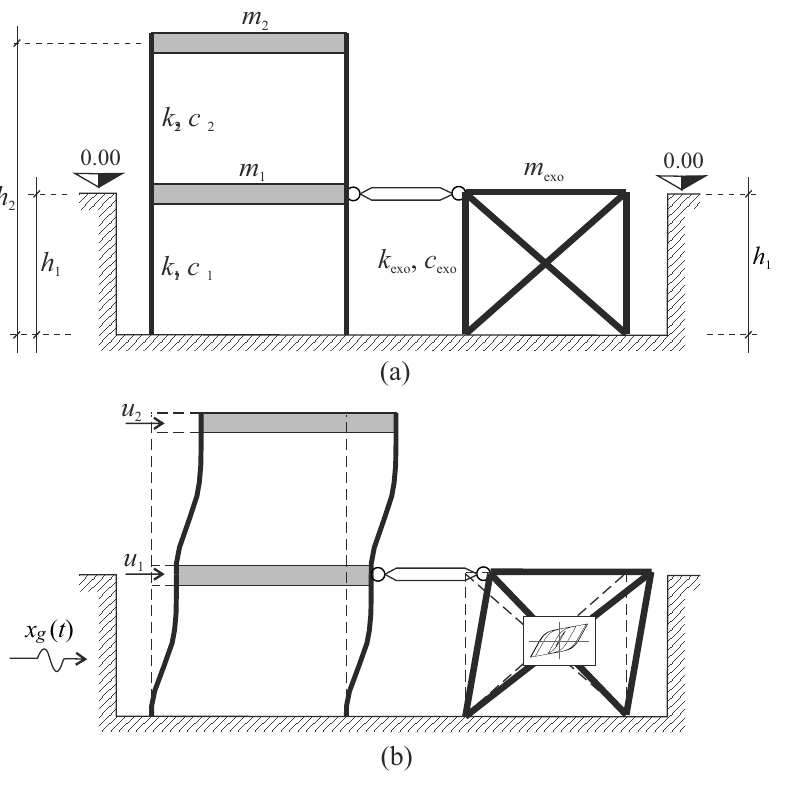
Figure 2. Mechanical system: ( a ) geometric and mechanical characteristics of the system; ( b ) deformed configuration and positive directions of the Lagrangian